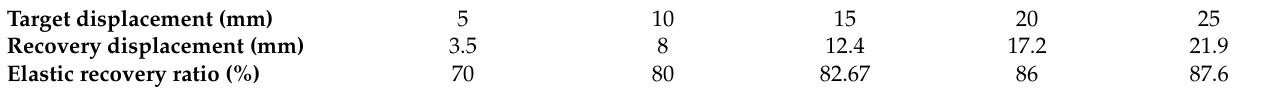
Figure 13. Lateral resistance according to cyclic loading. Table 5. Elastic recovery ratio according to target